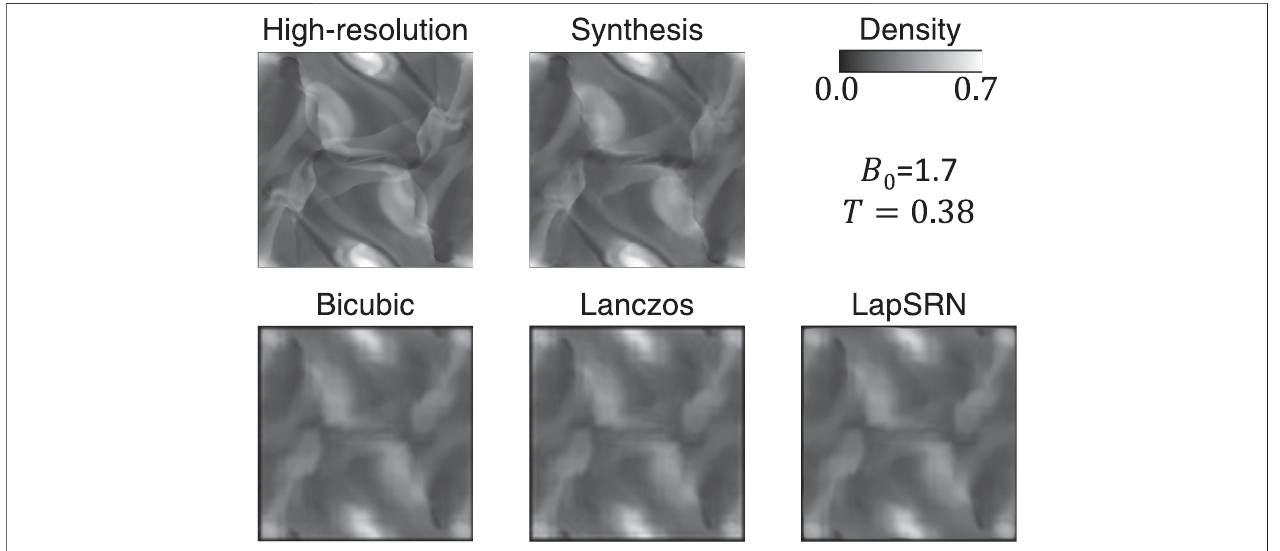
FIGURE 12 | Comparison of the results of the conventional super-resolution algorithms with that of the proposed method and ground truth.